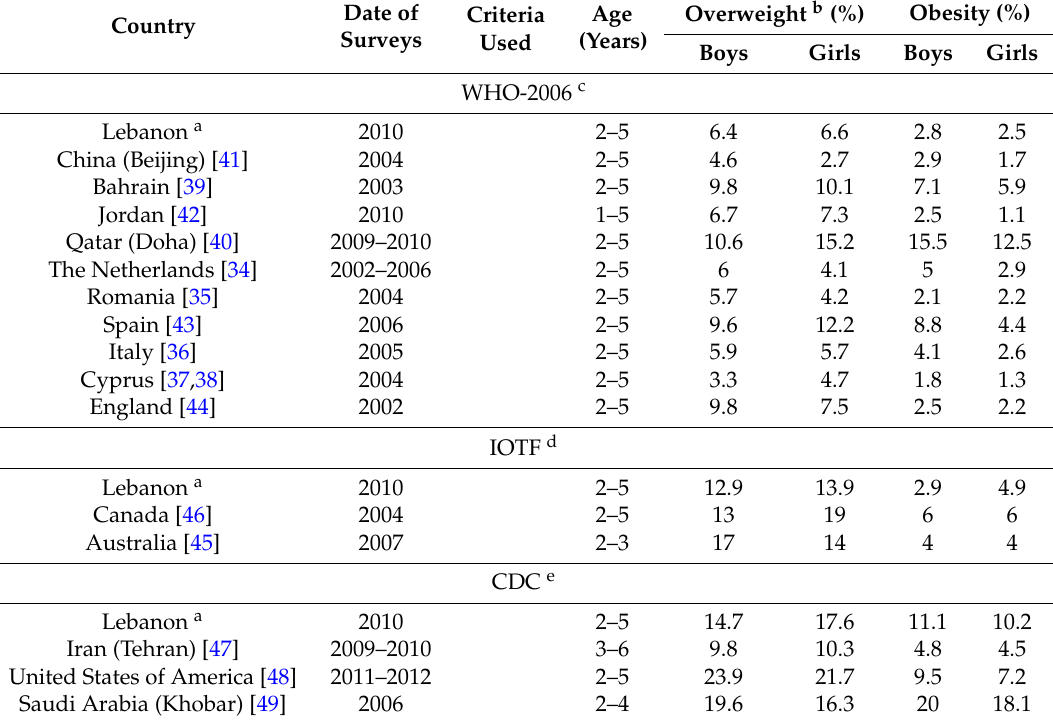
Table 4. Prevalence of overweight and obesity among Lebanese preschool children compared to those in selected